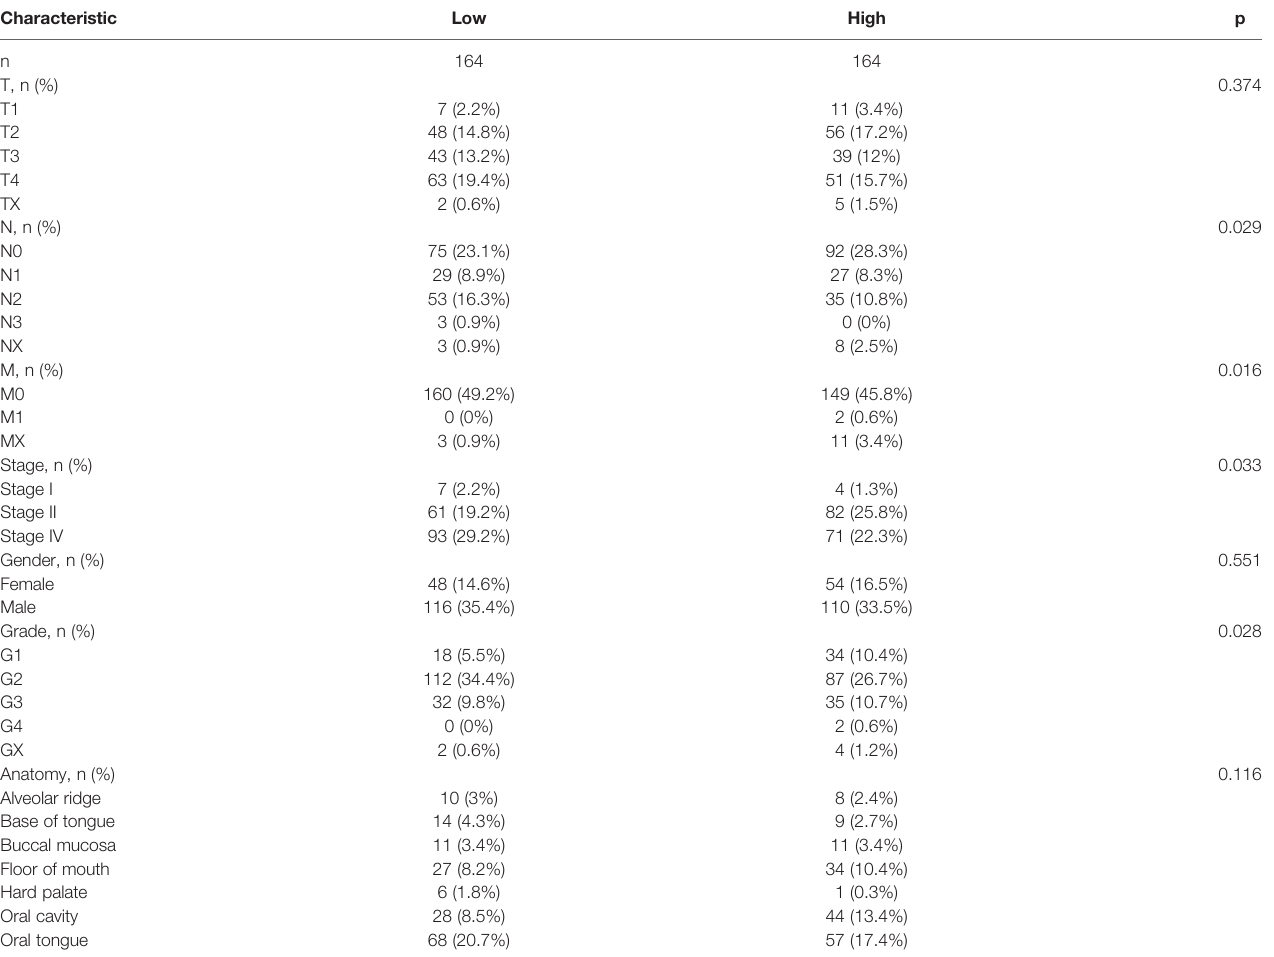
TABLE 1 | Patients ’ baseline